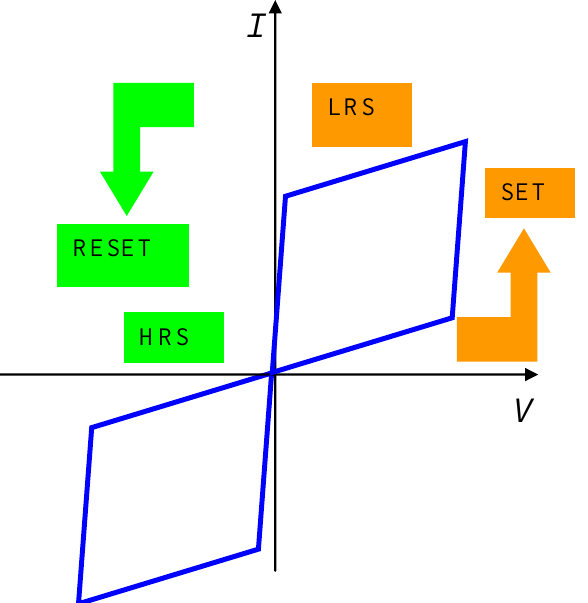
Figure 1. The schematic representation of a current-voltage dependence on a memristor.